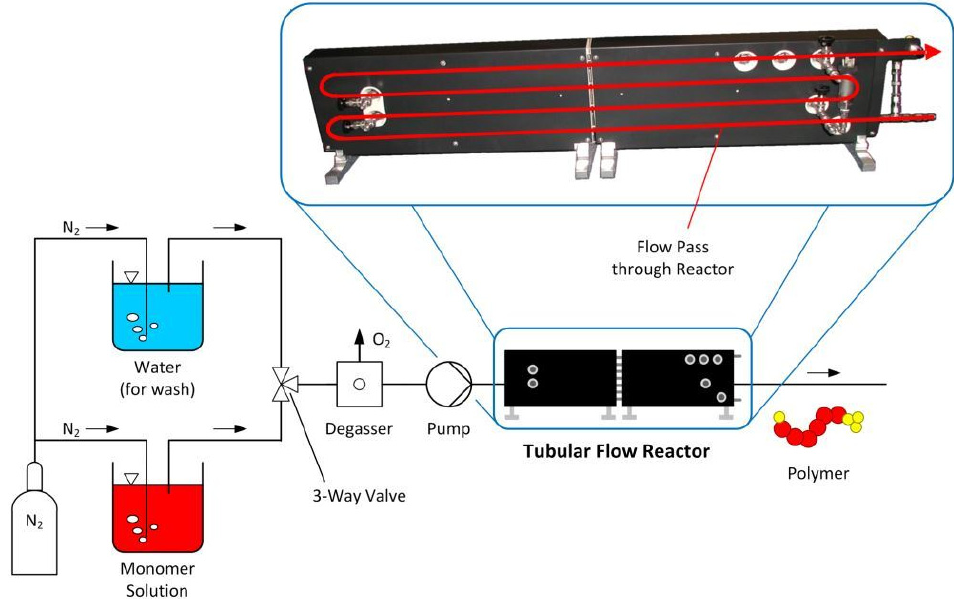
Figure 2. Flow diagram of the continuous Reversible Addition-Fragmentation Chain Transfer (RAFT) polymerization of water-soluble monomers; the magnified photograph on the top right shows the tubular flow reactor, highlighting the flow path through it in